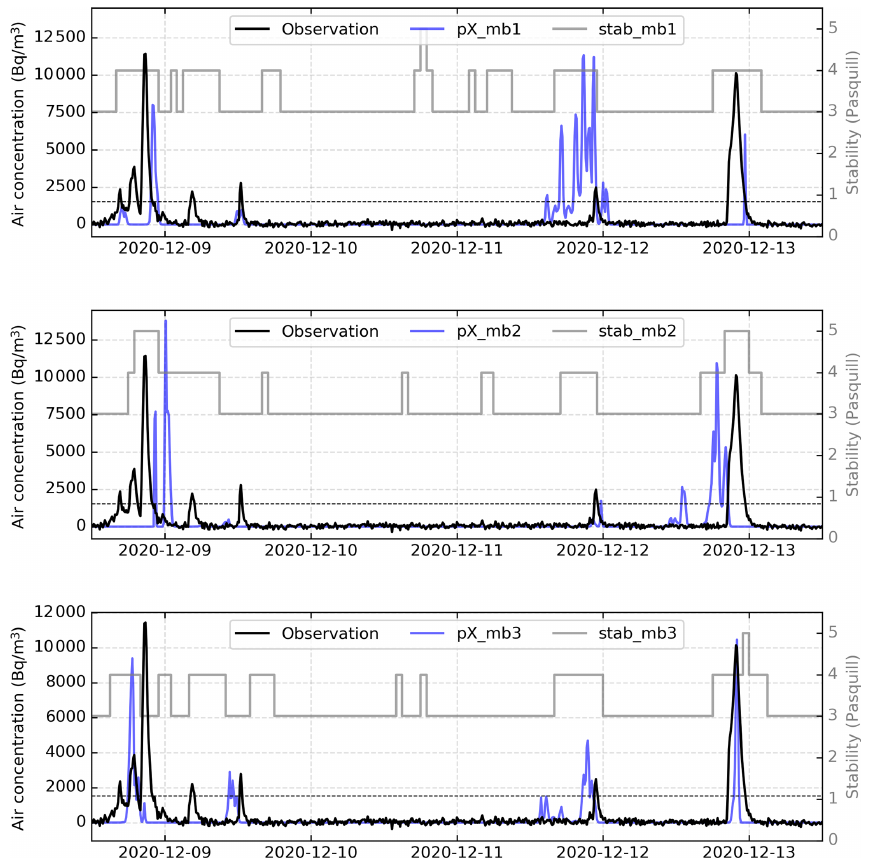
Figure 9. The three selected pX ensemble members (referred to as pX_mb1, pX_mb2, and pX_mb3) of 85 Kr activities, at the LRC site, from 8 December 2020 at 12:00UTC to 13 December 2020 at 12:00UTC. The gray curves represents the hourly Pasquill stability classes (referred to as stab_mb1, stab_mb2, and stab_mb3) used to generate each of the three pX members. The horizontal dashed line shows the air concentration threshold (1545Bqm − 3 ) above which peaks are